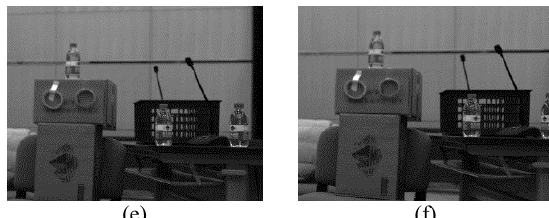
Fig. 14 Images the unmanned vehicle captured to perform the first experiment.